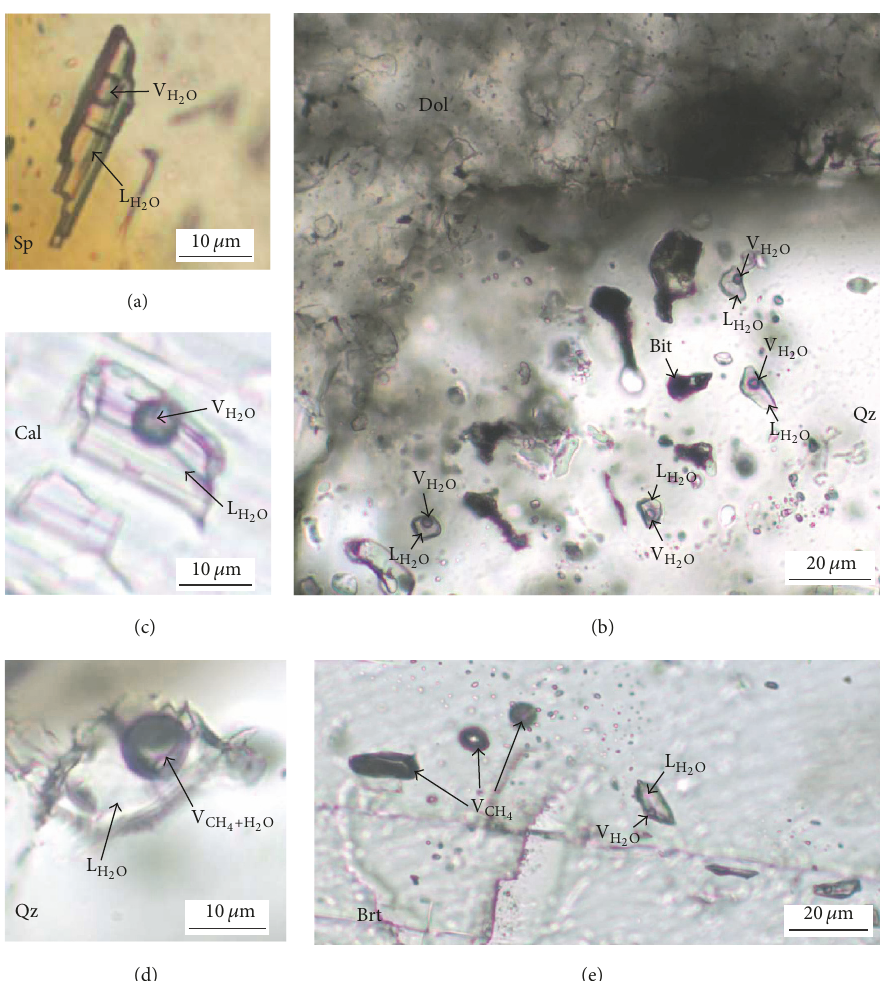
Figure 6: Photomicrographs of typical FIs hosted in different minerals of the Nanmushu Zn-Pb deposit, under transmitted light, crossed- nicols. (a) A brown grain sphalerite contains abundant FIs, including one relatively large type I FI. (b) In an automorphic quartz grain, there are abundant type I and type II FIs, which contain detectable bitumen. (c) One type I FI with liquid + vapor phase in calcite. (d) One two- phase CH 4 -rich inclusion in quartz is dominated by water with detectable methane. (e) CH 4 -rich inclusions with dark bubbles are dominated by detectable methane, coexisting with type I FIs in barite. Brt, barite; Cal, calcite; Dol, dolomite; Qz, quartz; Sp,